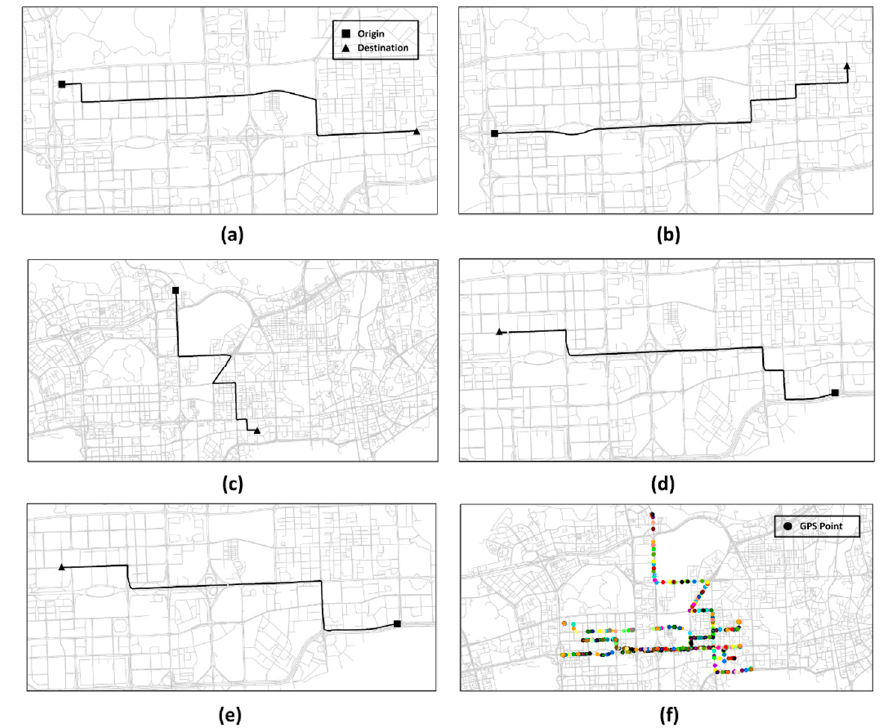
Figure 9. Spatial distribution of selected road paths and simulated GPS trajectories. ( a , b ) Road paths under scenario T 1 . ( c ) Road path under scenario T 2 . ( d , e ) Road paths under scenario T 3 . ( f ) Spatial distribution of simulated GPS trajectories.